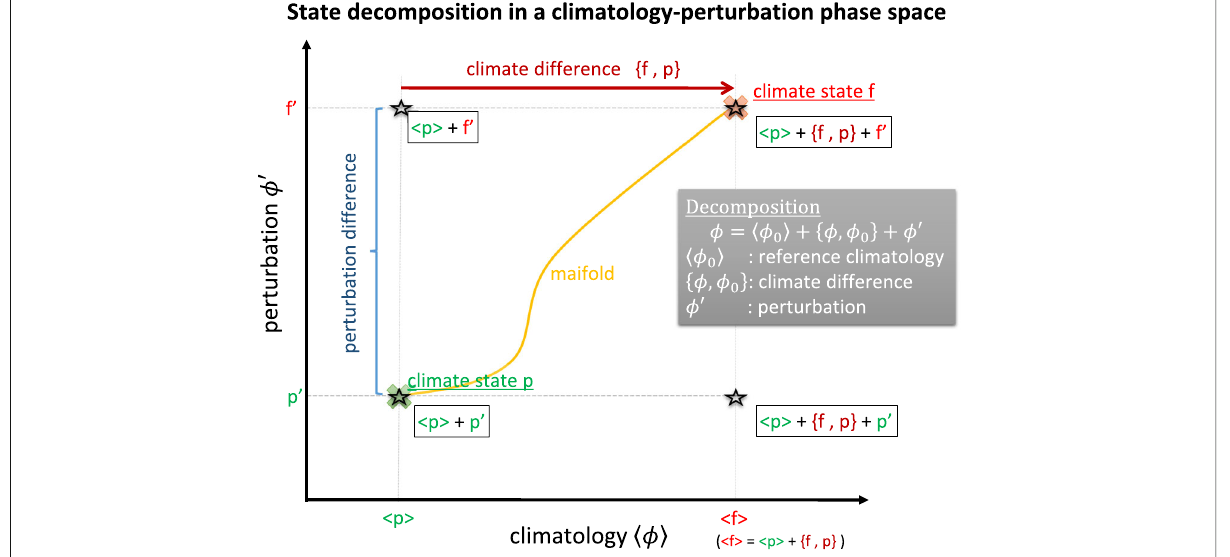
Fig. 1 Schematic diagram of the decomposition of the large-scale state in a climatology-perturbation phase space. Horizontal and vertical axes represent climatology and perturbation, respectively. For simplicity, climatology and perturbation are represented as scalar values. Cross marks show two states of a system. Stars represent the possible large-scale states driving the downscaling simulations. The yellow line shows the manifold corresponding to the relationship between climatology and